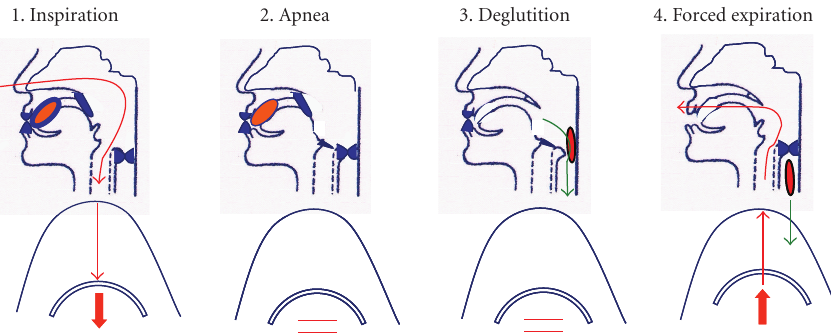
Figure 6: Diagrams showing the four steps of supraglottic swallow to protect the airway from aspiration. Commands for the patient are: (1) Take a deep breath, (2) Hold your breath, (3) Hold your breath while swallowing, (4) Cough immediately after you